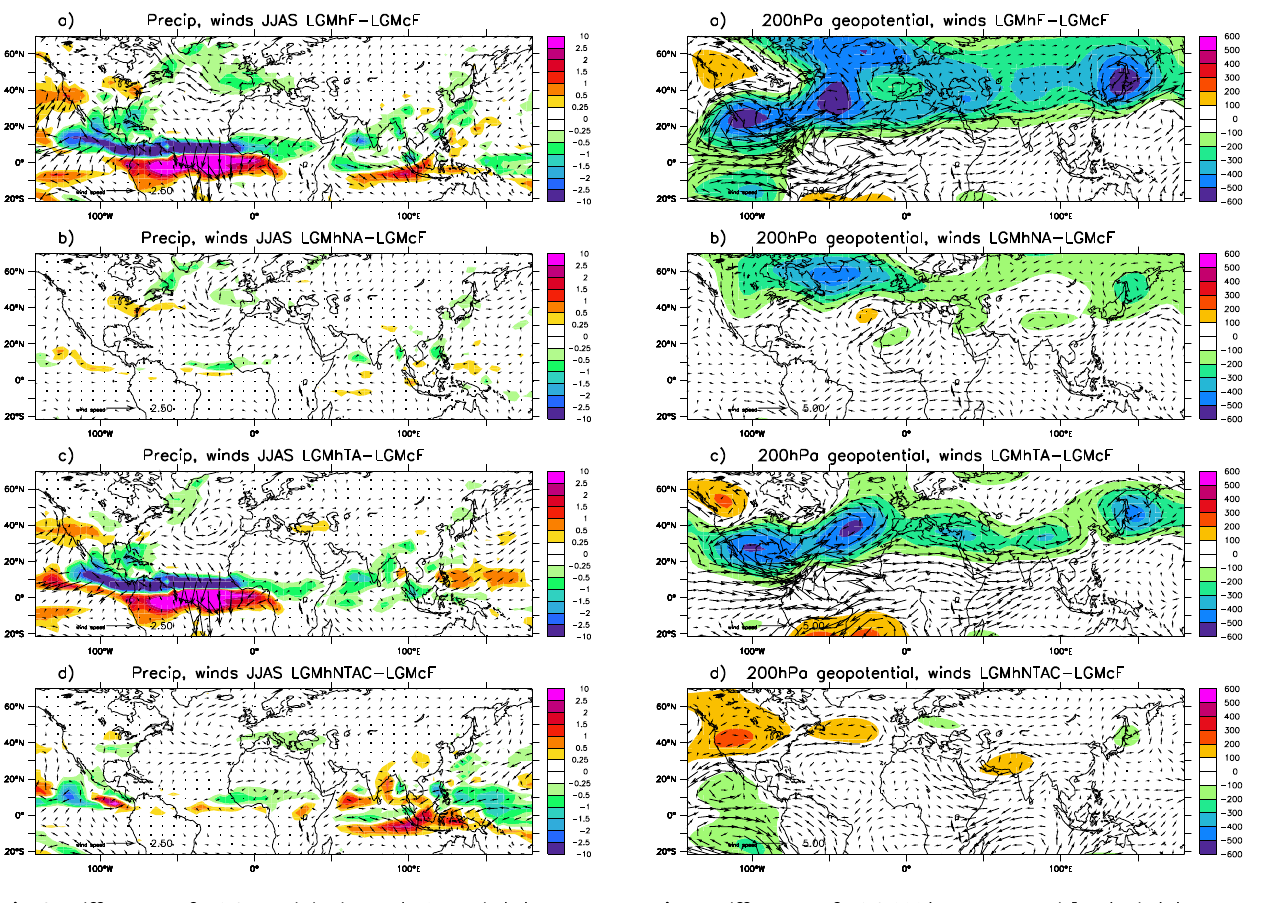
Fig. 6. Differences of JJAS precipitation and 10m winds between (a) LGMhF and LGMcF, (b) LGMhNA and LGMcF, (c) LGMhTA and LGMcF, (d) LGMhNTAC and LGMcF.